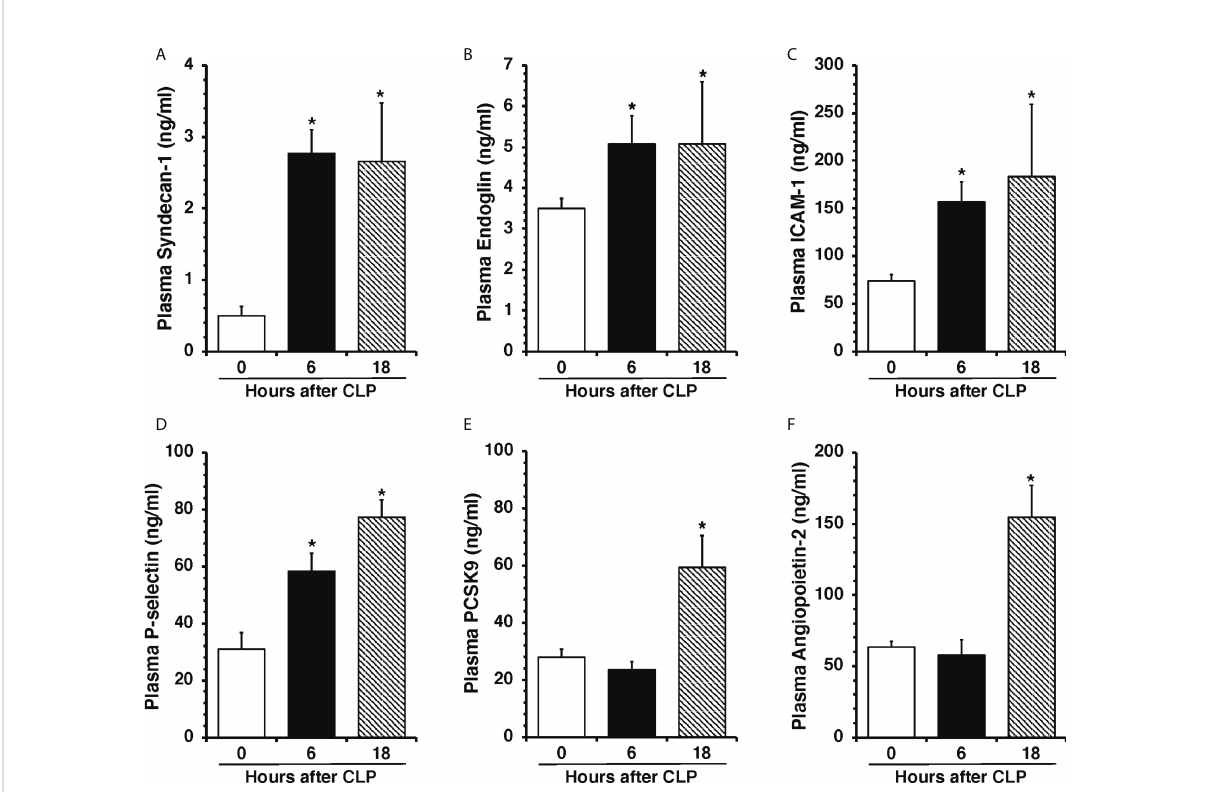
FIGURE 1 Plasma levels of Syndecan-1 (A) , Endoglin (B) , ICAM-1 (C) , P-selectin (D) , PCSK9 (E) , and Angiopoietin-2 (F) at 0 h, 6 h and 18 h after cecal ligation and puncture (CLP). Data represents the mean ± SEM of 10-13 mice for group (n=10 control group at 0 h, n=13 at 6 h, n=11 at 18 h). *Represents P < 0.05 versus control mice at time